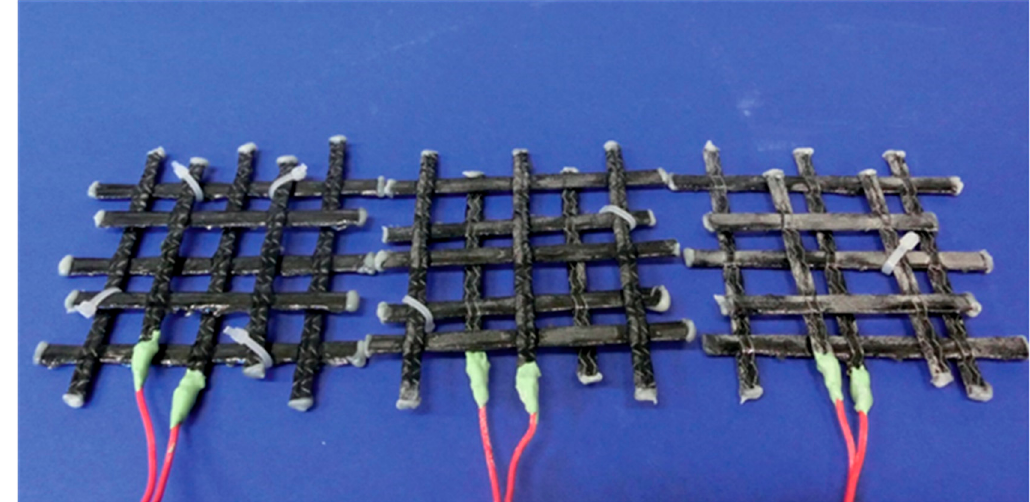
Figure 7. From left to right: Anodes E4 of levels 1 to 3 after polarization. Appl. Sci. 2018 , 8 , x FOR PEER REVIEW